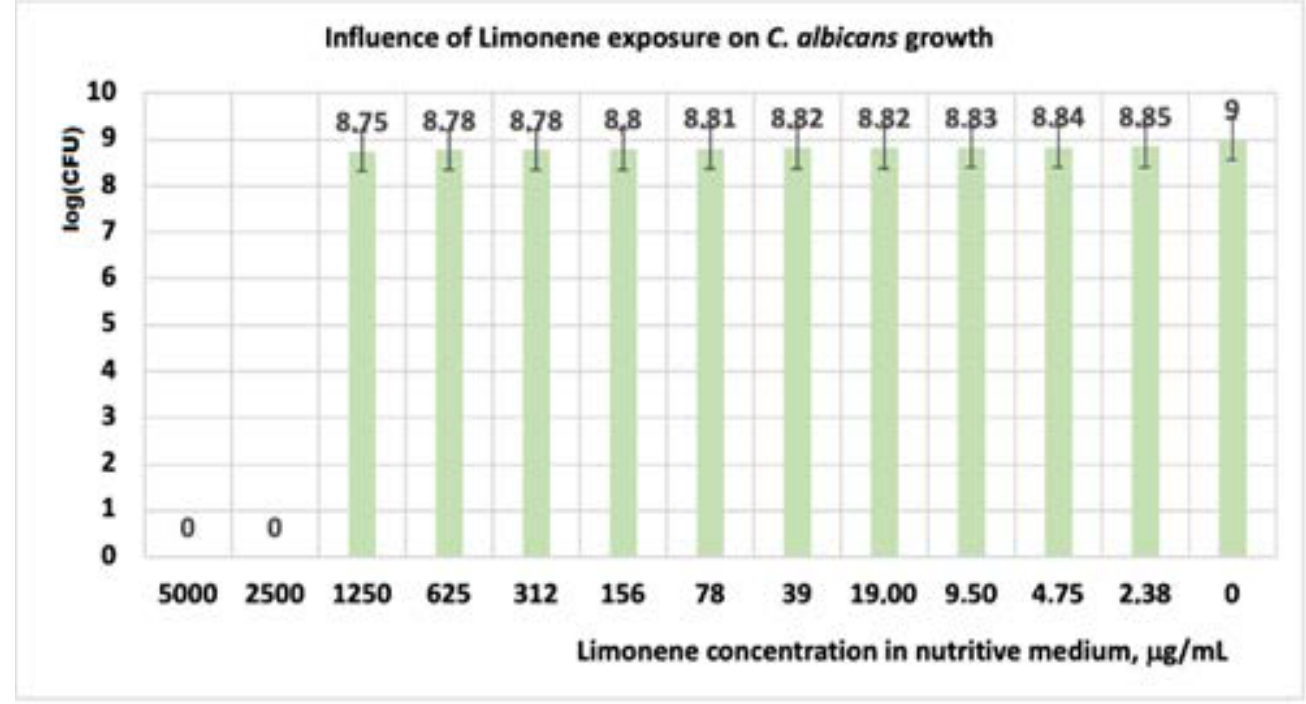
Figure 5. Influence of limonene exposure on C. albicans growth, after 48 h. At a concentration of limonene in the culture medium higher than 1250 μg/mL, C. albicans is inhibited.